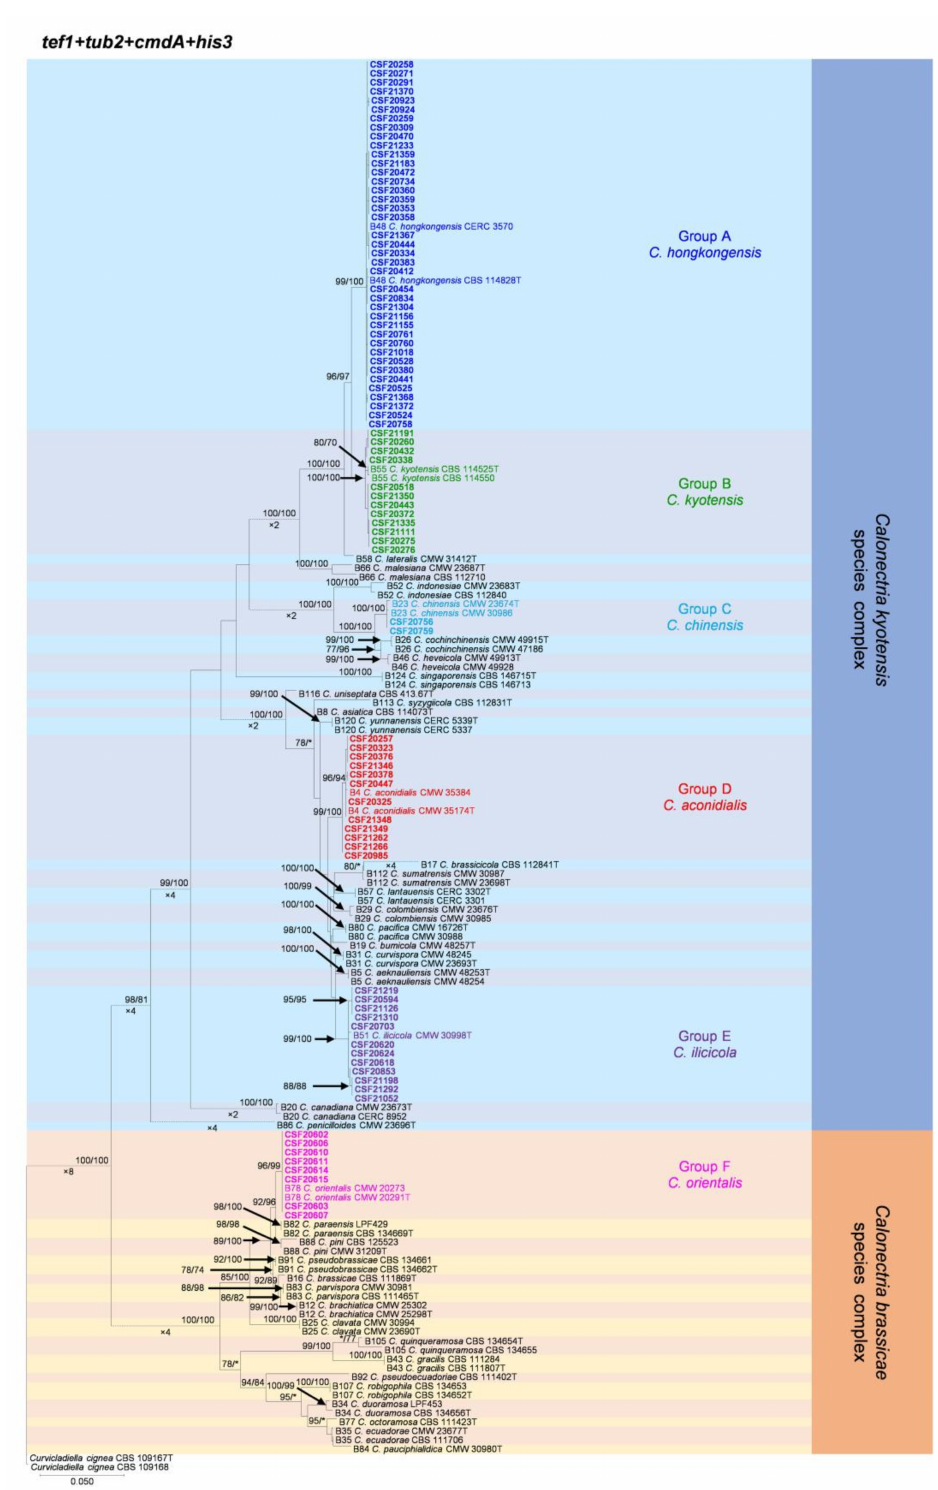
Figure 2. Phylogenetic tree of Calonectria species based on maximum likelihood (ML) analyses of the dataset of combined tef1 , tub2 , cmdA , and his3 gene sequences in this study. Bootstrap support values ≥ 70% are presented above the branches as follows: ML/MP. Bootstrap values < 70% or absent are marked with “*”. Isolates highlighted in six different colors, and bold were obtained in this study. Ex-type isolates are marked with “T”. The “B” species codes are consistent with the recently published results in Liu and co-authors [5]. Curvicladiella cignea (CBS 109167 and CBS 109168) was used as the outgroup